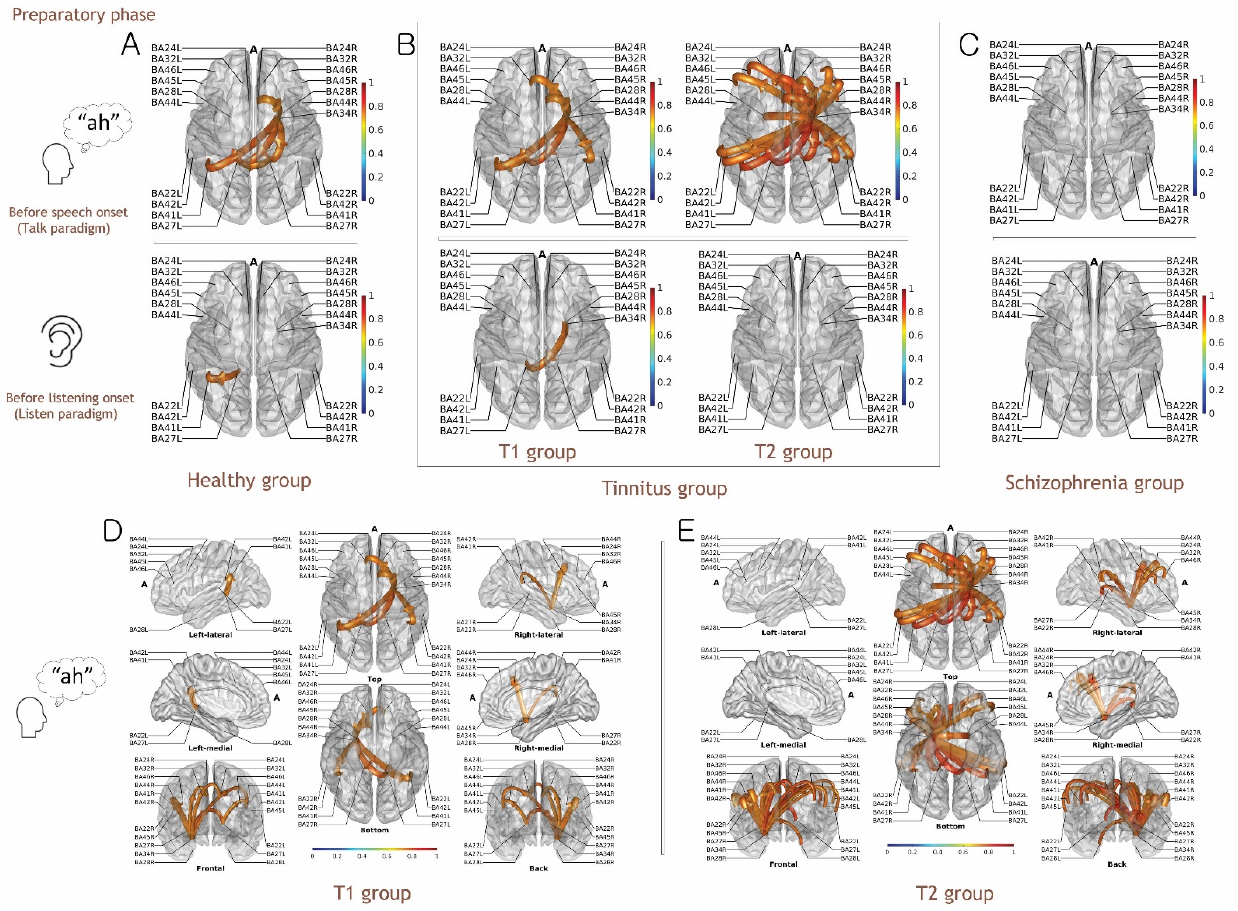
Figure 2. Granger causal connectivity of grand ‐ averaged evoked alpha activity during an auditory pre ‐ stimulus time window ( − 300 ms to 0 ms) in the Talk and Listen paradigm. ( A ) Healthy group. ( B ) Tinnitus groups: T1 (tinnitus without subjective hearing loss), T2 (tinnitus with subjective hear ‐ ing loss). ( C ) Schizophrenia group. ( D ) Spatial representation of connectivity in the T1 group. ( E ) Spatial representation of connectivity in the T2 group. Color ‐ scaled directional arrows link two causally connected regions of interest (ROIs) across 21 ROIs (BA24L/R, BA22L/R, BA27L/R, BA28L/R, BA32L/R, BA34R, BA41L/R, BA42L/R, BA44L/R, BA45L/R, and BA46L/R). Note that dur ‐ ing the auditory pre ‐ stimulus phase (before vocalization) of the Talk paradigm, outflows of infor ‐ mation from the right hippocampal regions (BA34R) to the left auditory cortex (BA41L) were ob ‐ served in the healthy group, suggesting a potential pathway of efference copy signals, which were found consistently in the T1 group. Notably, the outflows of information were more prominent in the T2 than in the T1 group, and additional outflows to the frontal regions were found in the T2 group. Interestingly, those functional connectivities were not observed in the schizophrenia group. (A: anterior). We speculated that the connectivities from the right STG and hippocampal region (BA34R) to the left parahippocampal region (BA27L) and primary auditory cortex (BA41L) for the preparatory phase of self ‐ generated vocalization might indicate active au ‐ ditory sensing for two reasons (Figure 2A). First, those connectivities were consistently observed in the healthy and T1 groups with a similar auditory attenuation pattern, and second, they were not observed in the preparatory phase of the passive listening para ‐ digm.